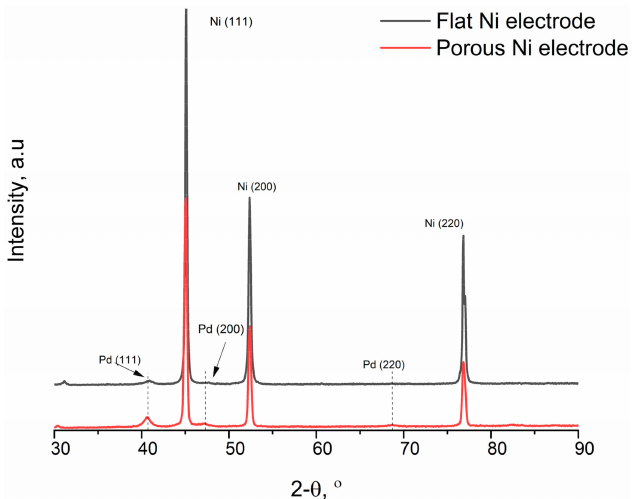
Figure 7. XRD diffraction patterns for flat Ni substrate (black) and Ni porous electrode (red) modified by Pd ions for 3600 s.